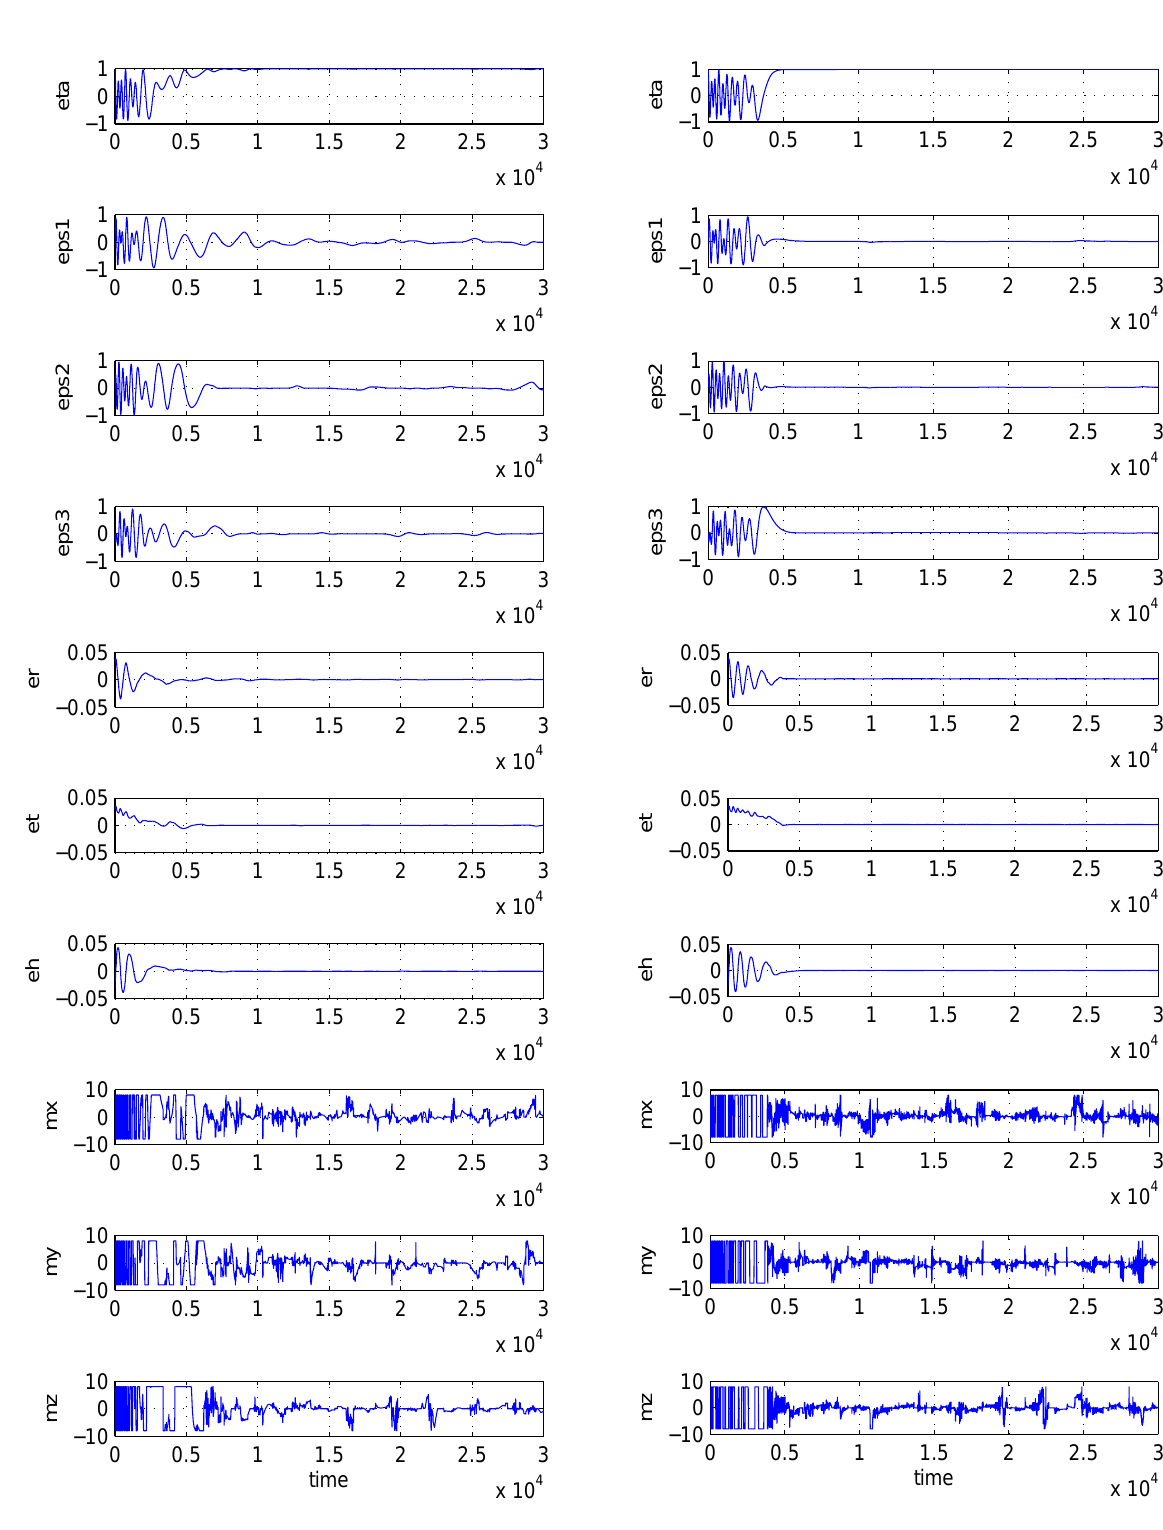
Figure 1: Attitude quaternion, angular velocity and control dipole moments for attitude acqui- sition using a PD controller with saturation and disturbance torque.